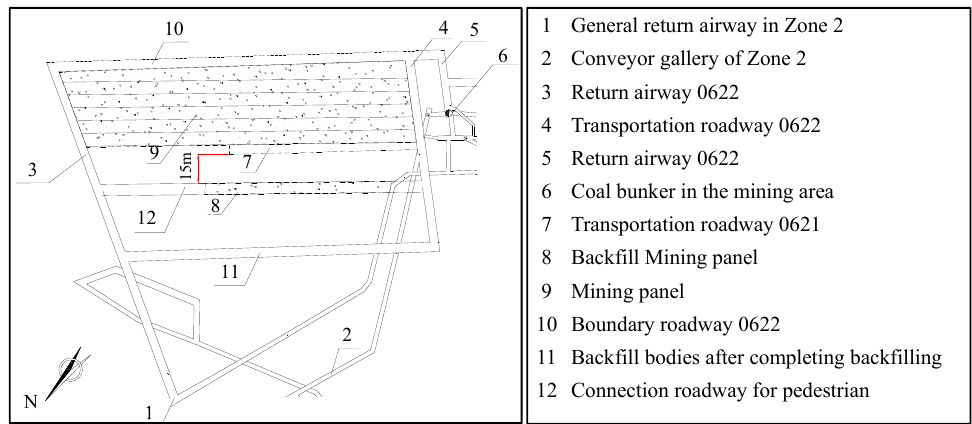
Figure 17. The layout of roadways and production system in the mining area.